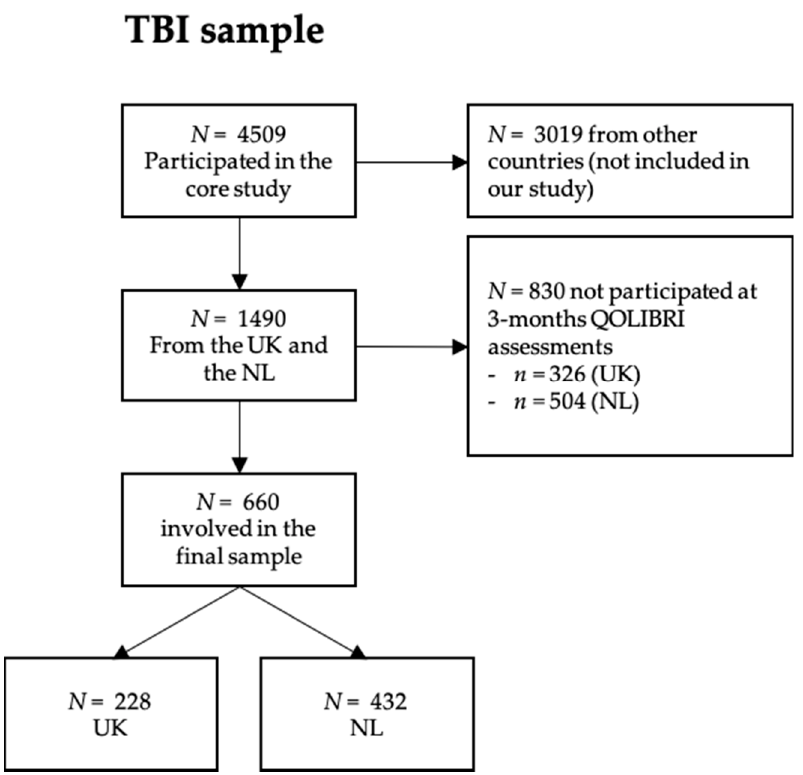
Figure 2. Sample attrition chart (traumatic brain injury (TBI) sample).